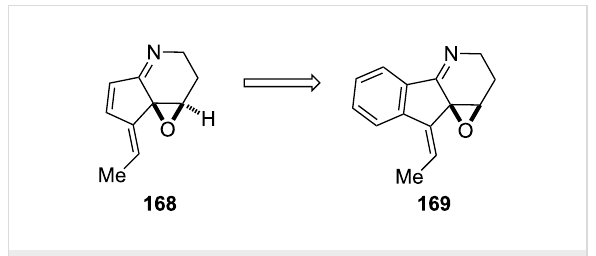
Figure 5: Chemical structure of abicoviromycin ( 168 ) and its new benzo derivative 169